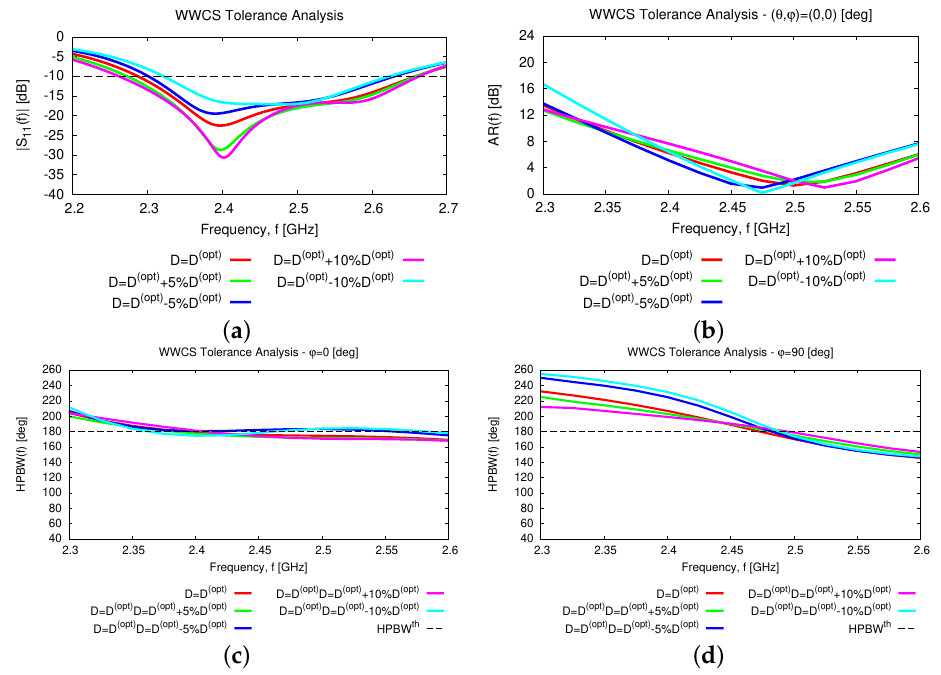
Figure 15. Numerical Assessment ( [ f min , f max ] = [ 2.3, 2.6 ] [GHz])—Behavior of the ( a ) reflection (cid:12) (cid:12) ( dB ) (cid:12) (cid:12) ( f , θ = 0, ϕ = 0 ) , and HPBW ( f ) along the ( c ) ϕ = 0 [deg] ( f ) coefficient, (cid:12) S (cid:12) , ( b ) axial ratio, AR 11 and ( d ) ϕ = 90 [deg] elevation planes of the WWCS radiating element when the height of the parasitic element, D , is affected by manufacturing deviations of ± 5% and ± 10% from the nominal value D ( opt ) (Table 2).